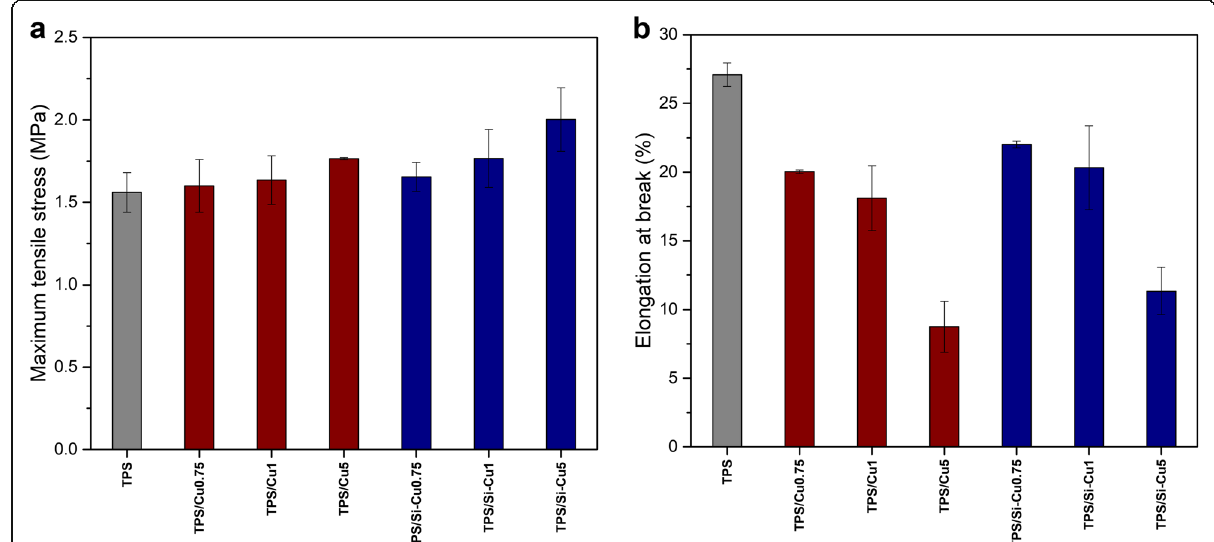
Fig. 5 Mechanical properties of TPS films containing Cu and Si-Cu particles at 1 and 5%: a ) maximum tensile strength and b ) elongation at break